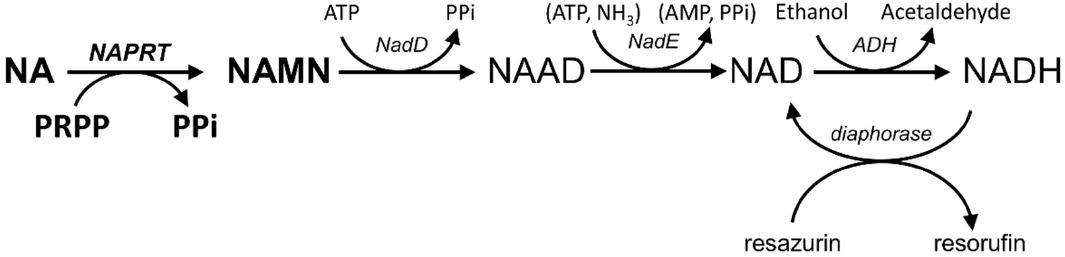
Figure 1. Fluorometric assays for NAPRT activity determination. The NADH assay couples NAPRT catalyzed reaction to conversion of NAMN to NADH by the sequential action of NAMN adenylyltransferase (NadD), NAD + synthase (NadE), and alcohol dehydrogenase (ADH). The resazurin/diaphorase-coupled assay couples NADH formation to the cycling reduction of resazurin to resorufin by diaphorase.